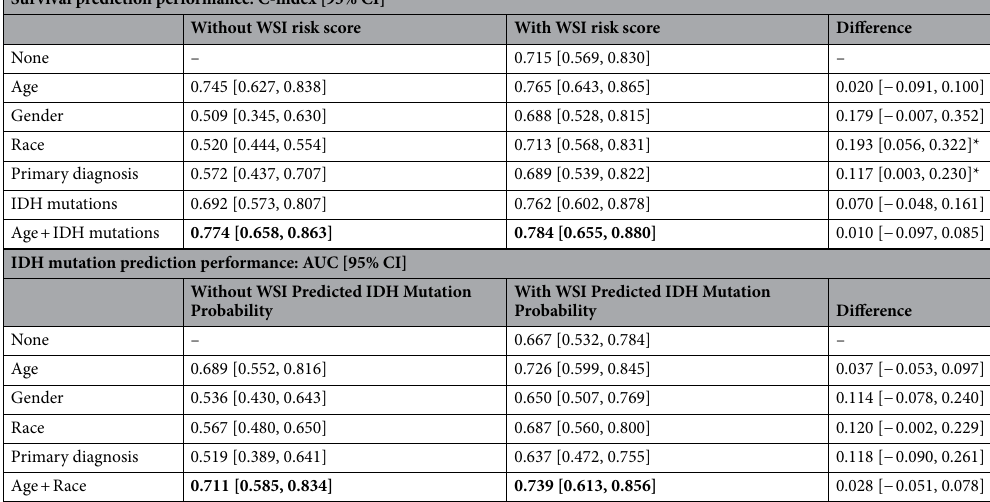
Table 1. Model performance statistics for survival prediction task and IDH mutation prediction task, evaluated among patients with grade 2 gliomas. 95% confidence intervals were derived from 10,000 bootstrapping replications. Bold texts indicate the best performance for each column. * Indicates statistically significant difference ( p <